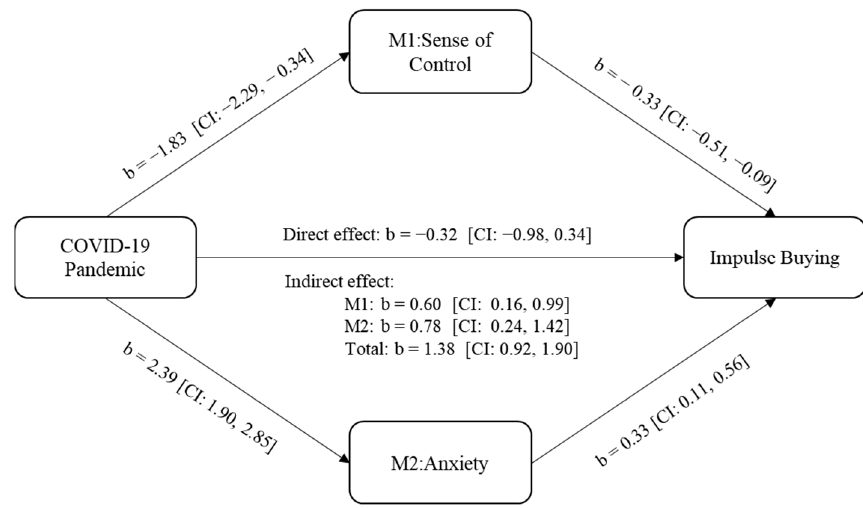
Figure 4. The mediating effect of sense of control and